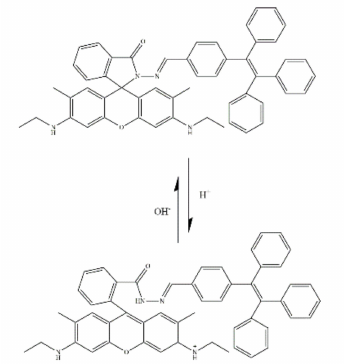
Figure 37. The response mechanism of BDP-RhB (Table 2, No. 5) to pH [80]. A novel aggregation-induced emission target molecule was proposed by Liu Z., et al. (Table 2, No. 6) [81], acquired from rhodamine 6G hydrazine and tetrastyrene carbaldehyde through a high boiling solvent (DMF/H 2 O) volatilization method. The change in pH induced spiro ring opening structure and the color change (colorless to pink) of the prepared sensor (Figure 38).